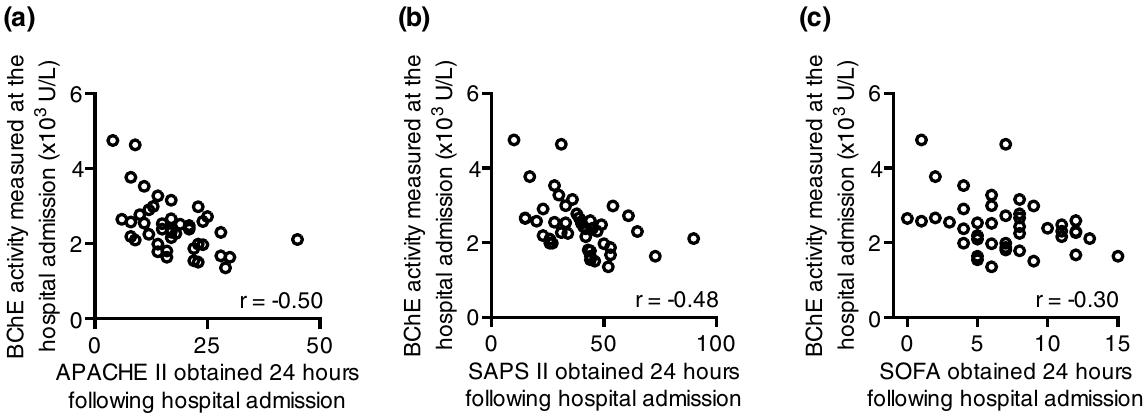
Figure 2. The BChE activity measured upon arrival to the hospital correlates with the disease severity scores obtained 24 hours later. Scatter diagrams represent a correlation of the BChE activity, measured from major trauma patients at the hospital admission and the APACHE II ( a ), SAPS II ( b ) and SOFA ( c ) scores obtained 24 hours later. r – Spearman correlation coefficient; APACHE II - Acute Physiology And Chronic Health Evaluation II; SAPS II - Simplified Acute Physiology Score; SOFA - Sequential Organ Failure